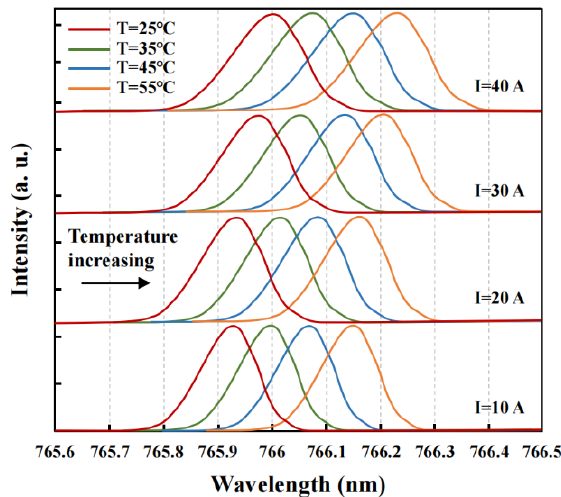
Figure 5. Tunable spectrum of locked CS lasers with increasing heating temperature at different operating currents.